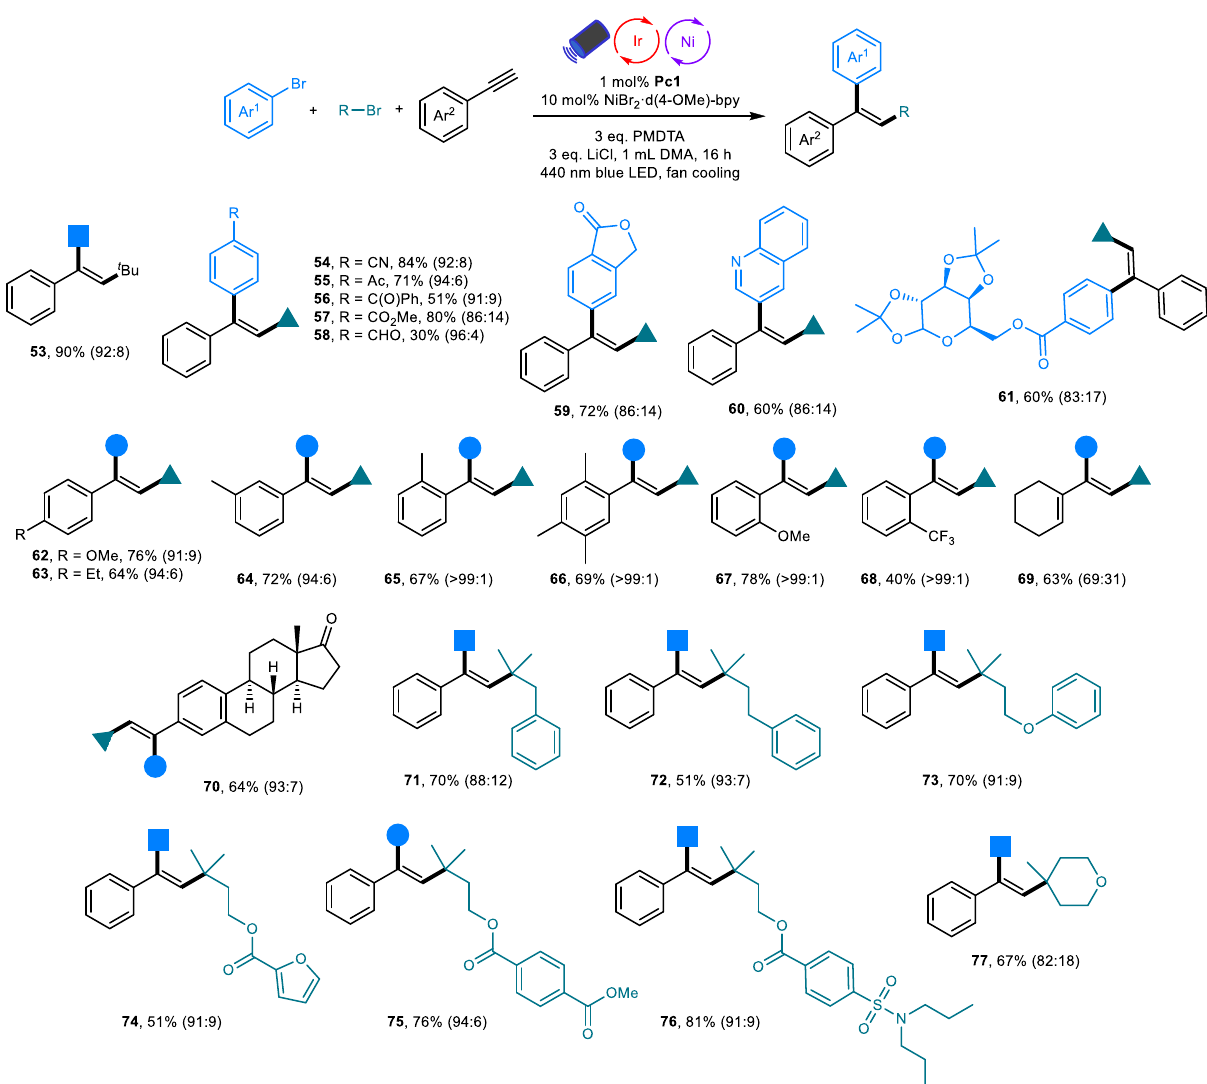
Fig. 3 Scope of the photoredox/nickel dual catalyzed arylalkylation of alkynes. Reactions were performed with 0.4 mmol of aryl bromides, 0.2 mmol of alkynes, and 0.6 mmol of alkyl bromide. Yields are of isolated products. The values in parentheses represent the ratio of the two isomers ( P syn : P anti ), which was determined by 1 H NMR